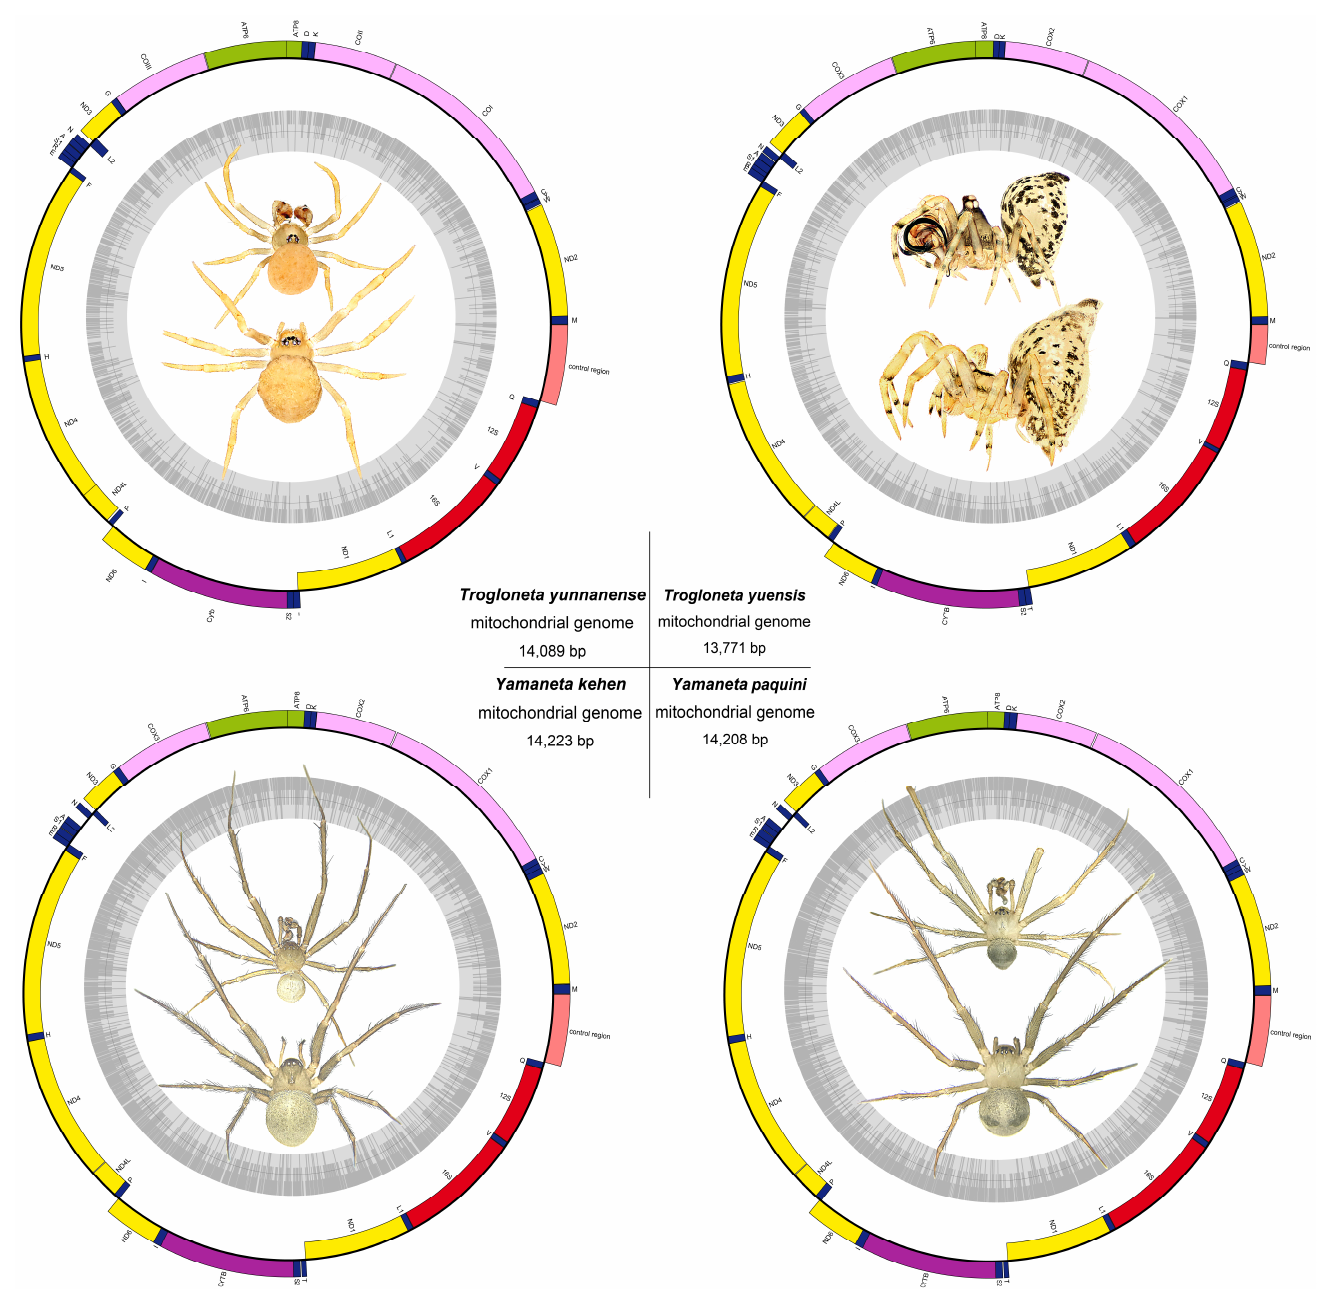
Figure 1. Circular maps of the mitogenomes of four Mysmenidae species. Protein-coding and ribosomal genes are shown with standard abbreviations. The total numbers of non-stop codons in T. yunnanense , T. yuensis , Y. kehen and